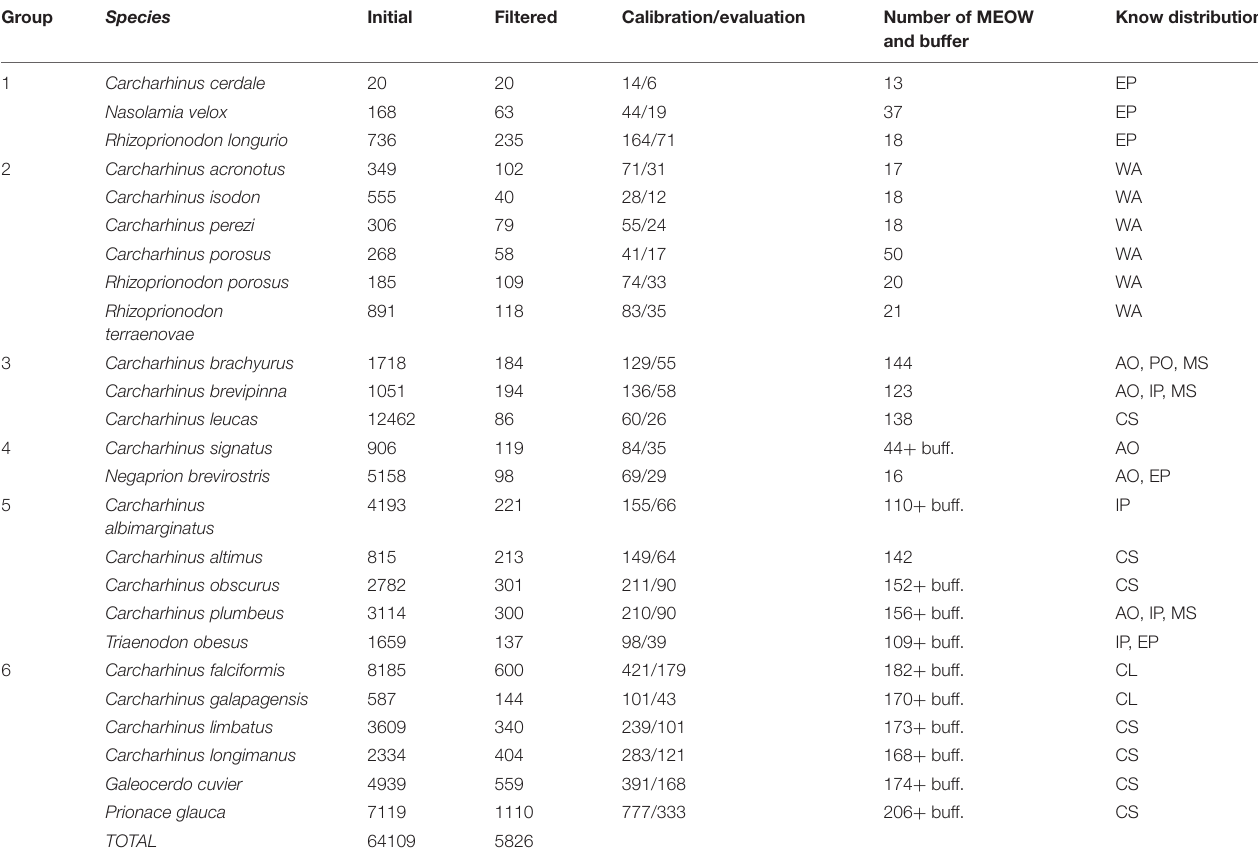
TABLE 1 | List of modeled species, divided into groups according to their M